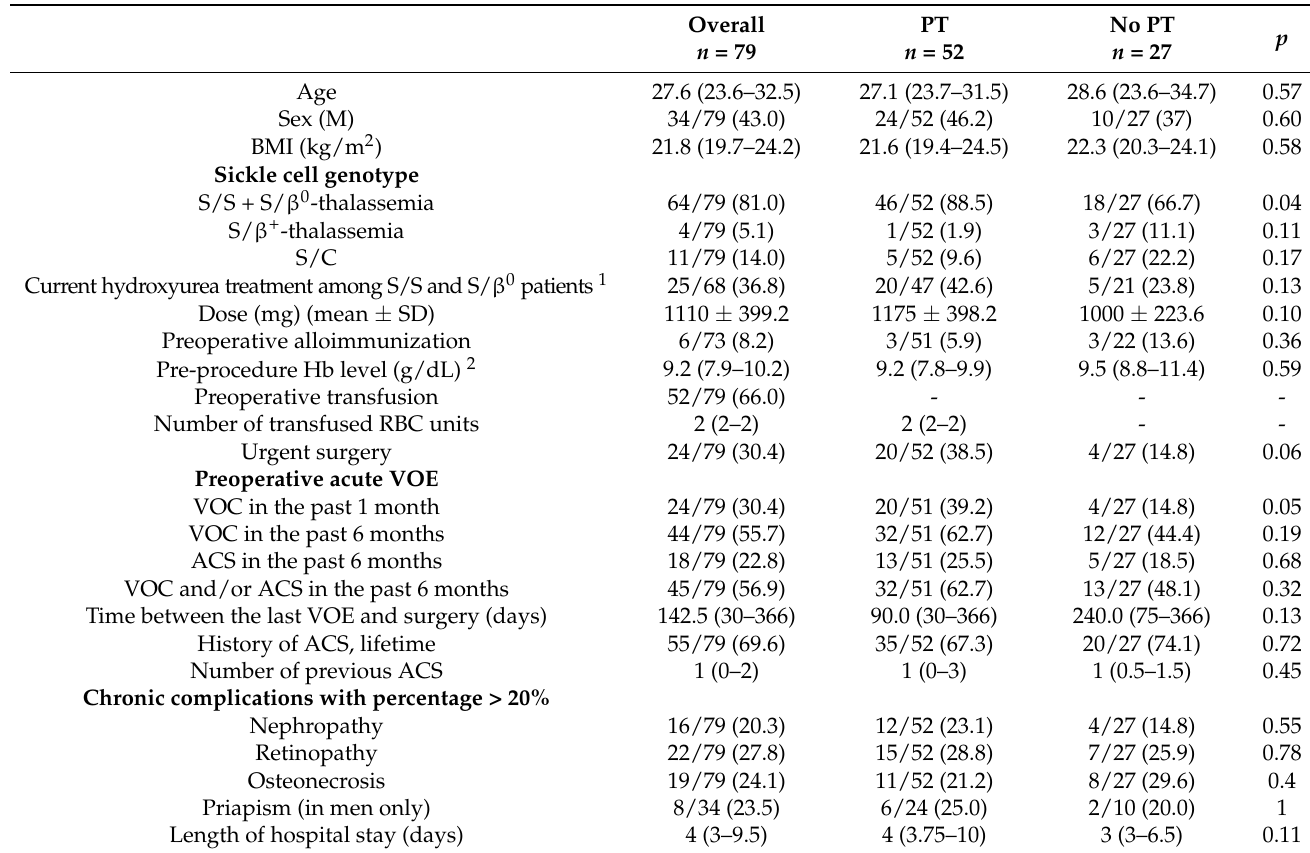
Table 1. Patients’ characteristics and comparison according to prophylactic